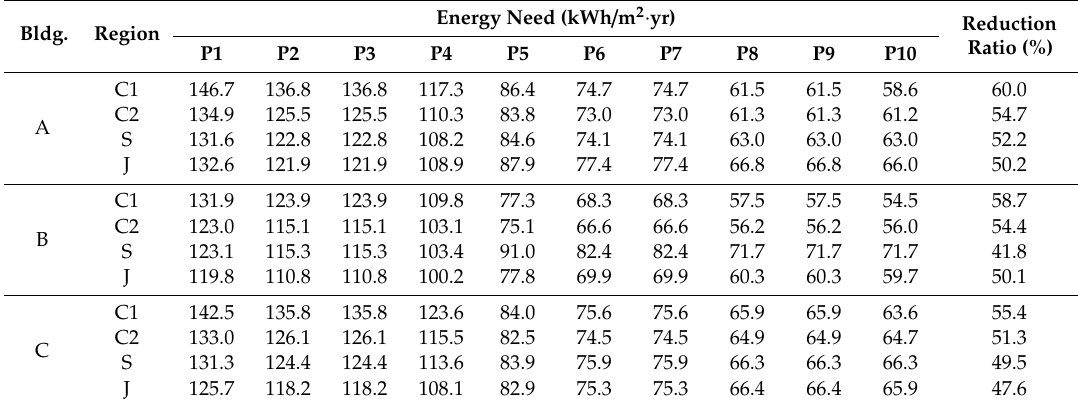
Table 10. The energy need of the reference buildings according to the reinforcement of the BECC. Bldg.